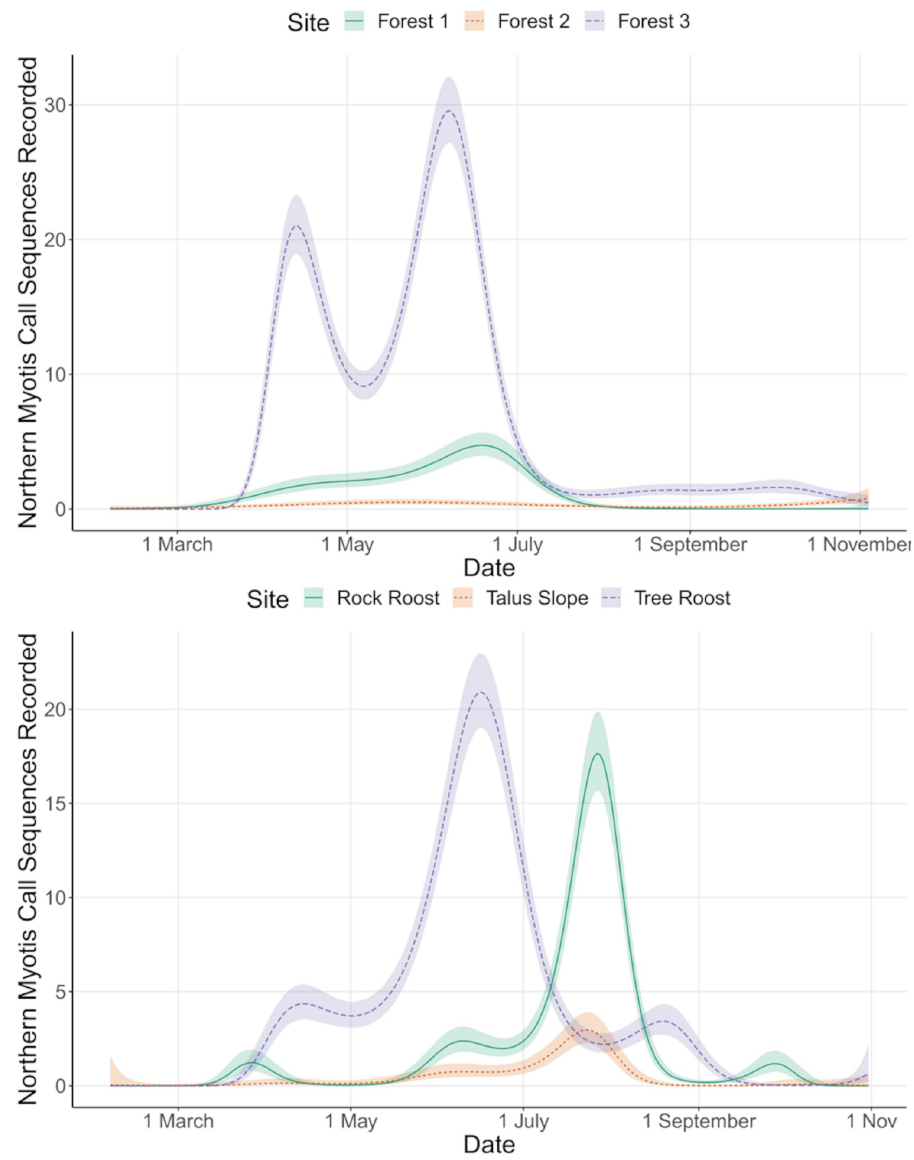
Fig 6. Seasonal trends in nocturnal activity of northern myotis. Acoustic activity of northern myotis recorded at six locations in central Pennsylvania from February–December 2020. Activity recorded at forested corridors where northern myotis were captured (A) and outside maternity roosts (B) peaked earlier in the year than activity outside the rock hibernaculum (B). Data are smoothed as a function of ordinal data and detector site, created using a generalized additive